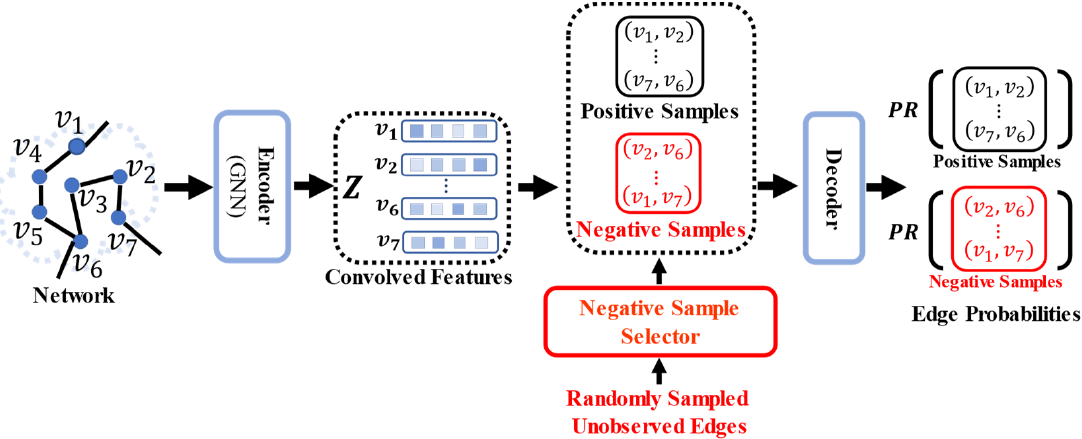
Figure 2. The training procedure of GNN models with the proposed PbTRM in the link prediction task. GNN models are used as the encoder to extract the convolved features of nodes in the input network. The decoder calculates the edge probabilities PR ( · ) of positive and negative samples.